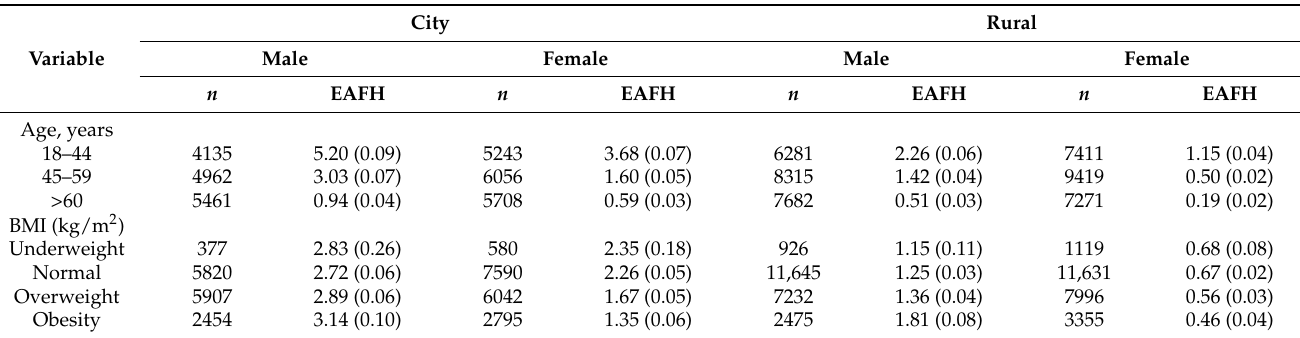
Table A2. Distribution of frequencies of eating-away-from-home (EAFH) of different sexes and ages in urban and rural areas.